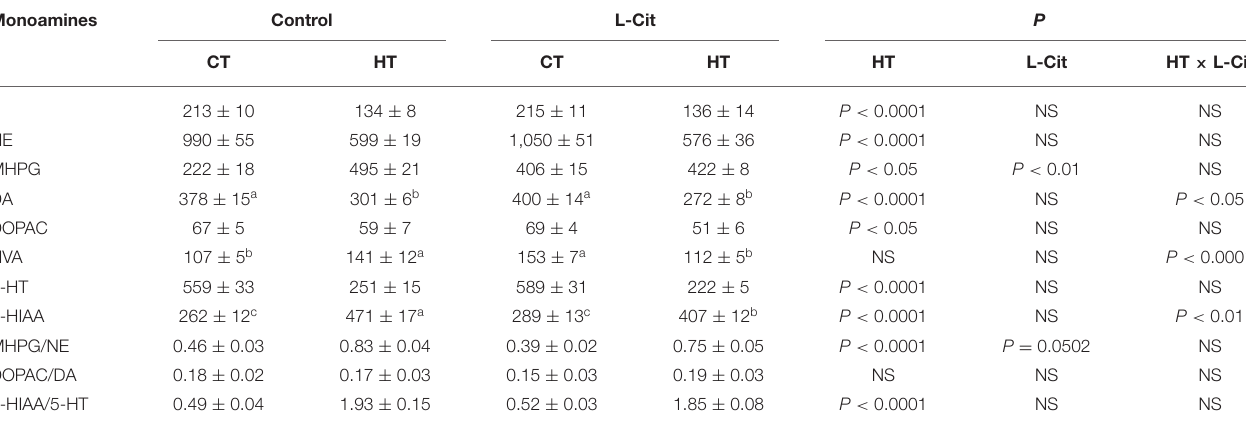
TABLE 3 | Effects of oral administration of L-Cit on concentrations of monoamines and their metabolites in the diencephalon of broilers.